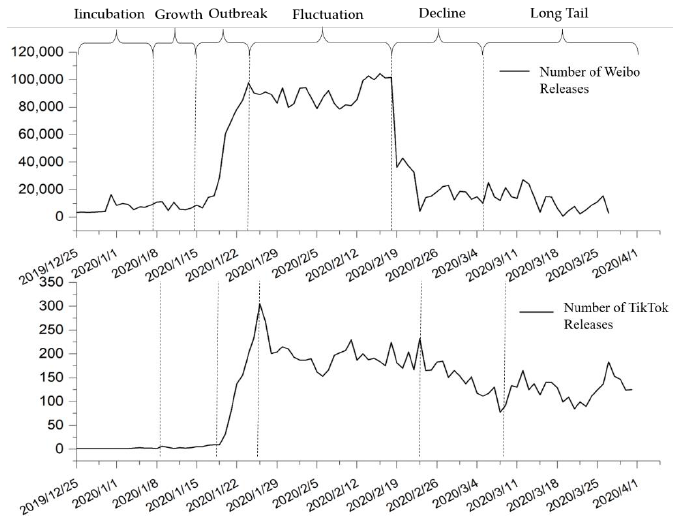
Figure 5. Stage division of life cycle of Weibo and TikTok platform events.